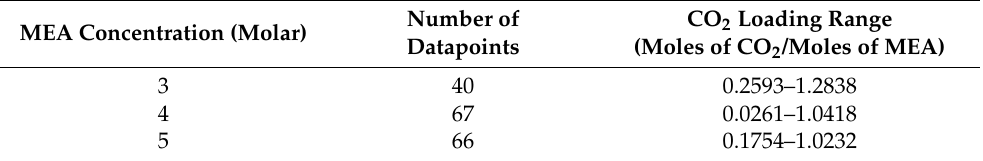
Table 2. Table of materials for the